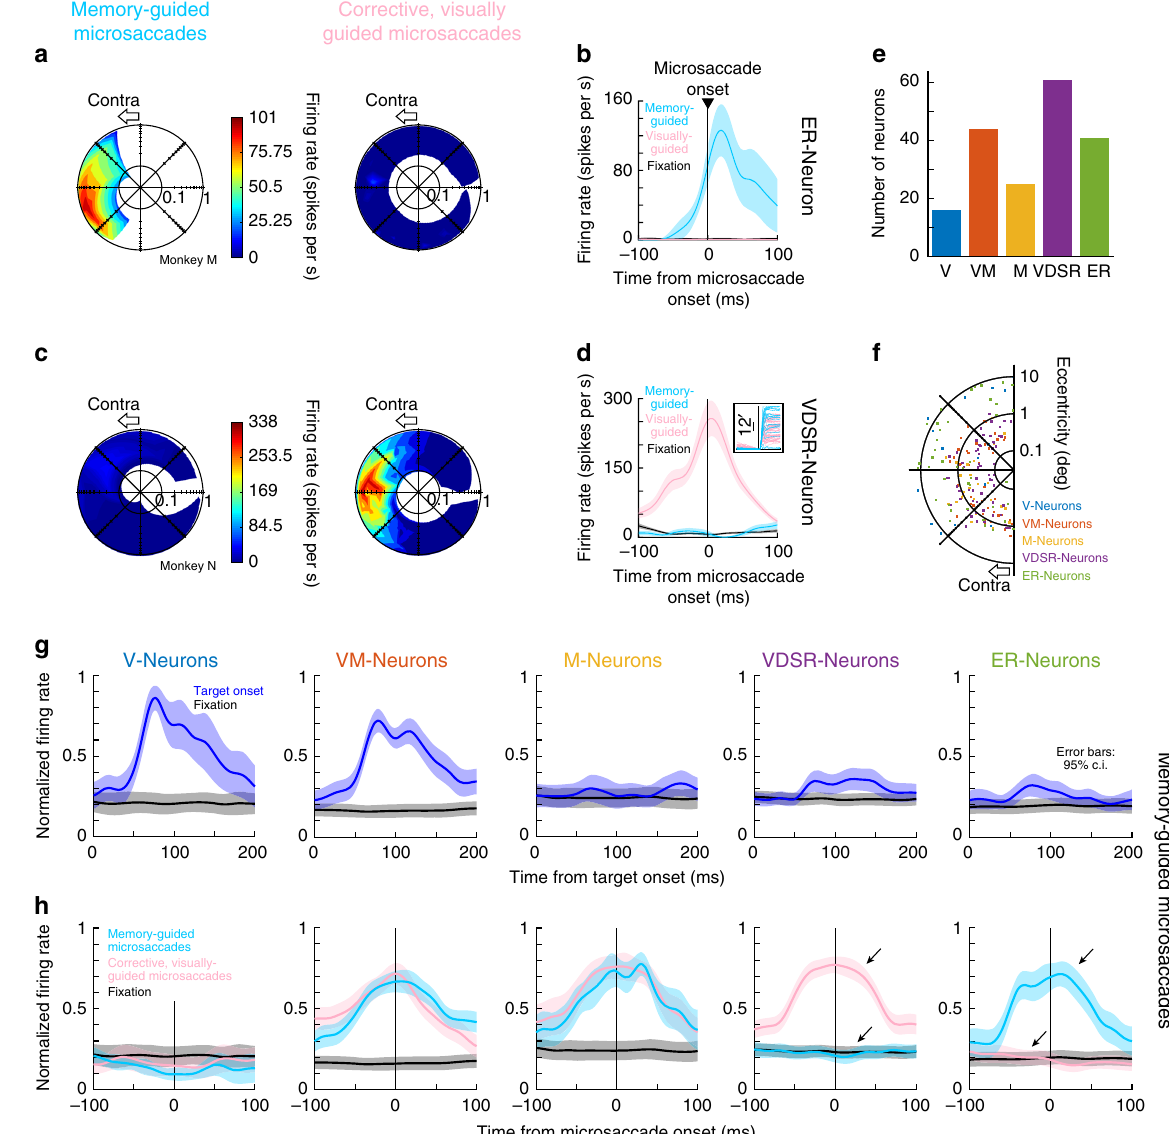
Fig. 7 Double dissociation of SC microsaccade-related discharge for visually- and memory-guided microsaccades. a Movement RF ’ s of an example SC neuron. Left shows peri-movement discharge (like in Fig. 6b) for memory-guided microsaccades; right shows the same for corrective, visually-guided microsaccades. The neuron was silent for the visually-guided movements, but not for similar-sized memory-guided ones. b Peri-movement discharge of the same neuron under the two conditions. The black curve (when visible) shows the neuron ’ s activity during fi xation before trial onset; the neuron only discharged for memory-guided, but not visually guided, microsaccades. Error bars denote 95% con fi dence intervals. c , d Same as a , b but for an example neuron only showing microsaccade-related discharge for visually guided movements (similar to visually dependent saccade-related, VDSR, neurons 46 ). The inset shows (as an example) the analyzed eye movements (like Fig. 6a) in the two conditions, demonstrating clear overlap (similar overlap was present in a , b ). e Distribution of the different neuron types (V = Visual; VM = Visual-motor; M = Motor; VDSR = Visually-dependent saccade-related; ER = Exclusively responding for memory-guided microsaccades). f Movement RF hotspots for the neurons. ER-Neurons tended to be more eccentric than other neurons exhibiting microsaccade-related discharge, consistent with a foveal expansion for memory-guided microsaccades (see text and Supplementary Fig. 5). g , h Peri-stimulus ( g ) or peri-microsaccadic ( h ) discharge for all of our encountered neuron types during microsaccade generation. Each neuron ’ s response was fi rst normalized before averaging responses across neurons. V- and VM-Neurons exhibited strong visual responses; VM- and M-Neurons showed movement-related activity regardless of stimulus; VDSR-Neurons only showed movement-related activity in the presence of a visual target; ER-Neurons only showed movement-related activity in the absence of a visual target. In all cases, we analyzed neural activity for microsaccades (<1 o ) toward the RF. Error bars denote 95% con fi dence